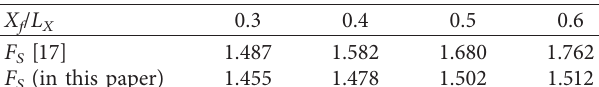
Table 2: Comparisons of the factor of safety ( H � 10 , c �